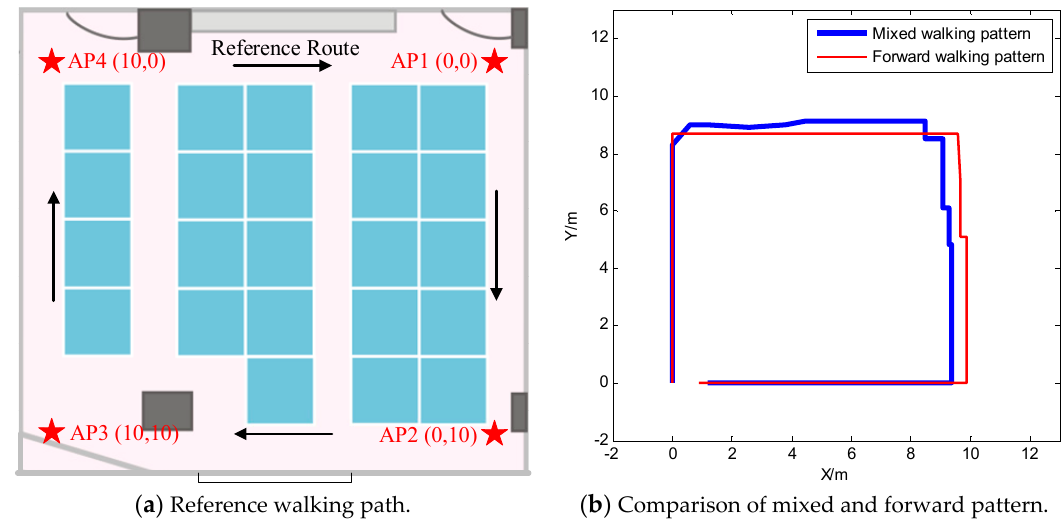
Figure 8. Comparison result of multi-pattern and forward-pattern.